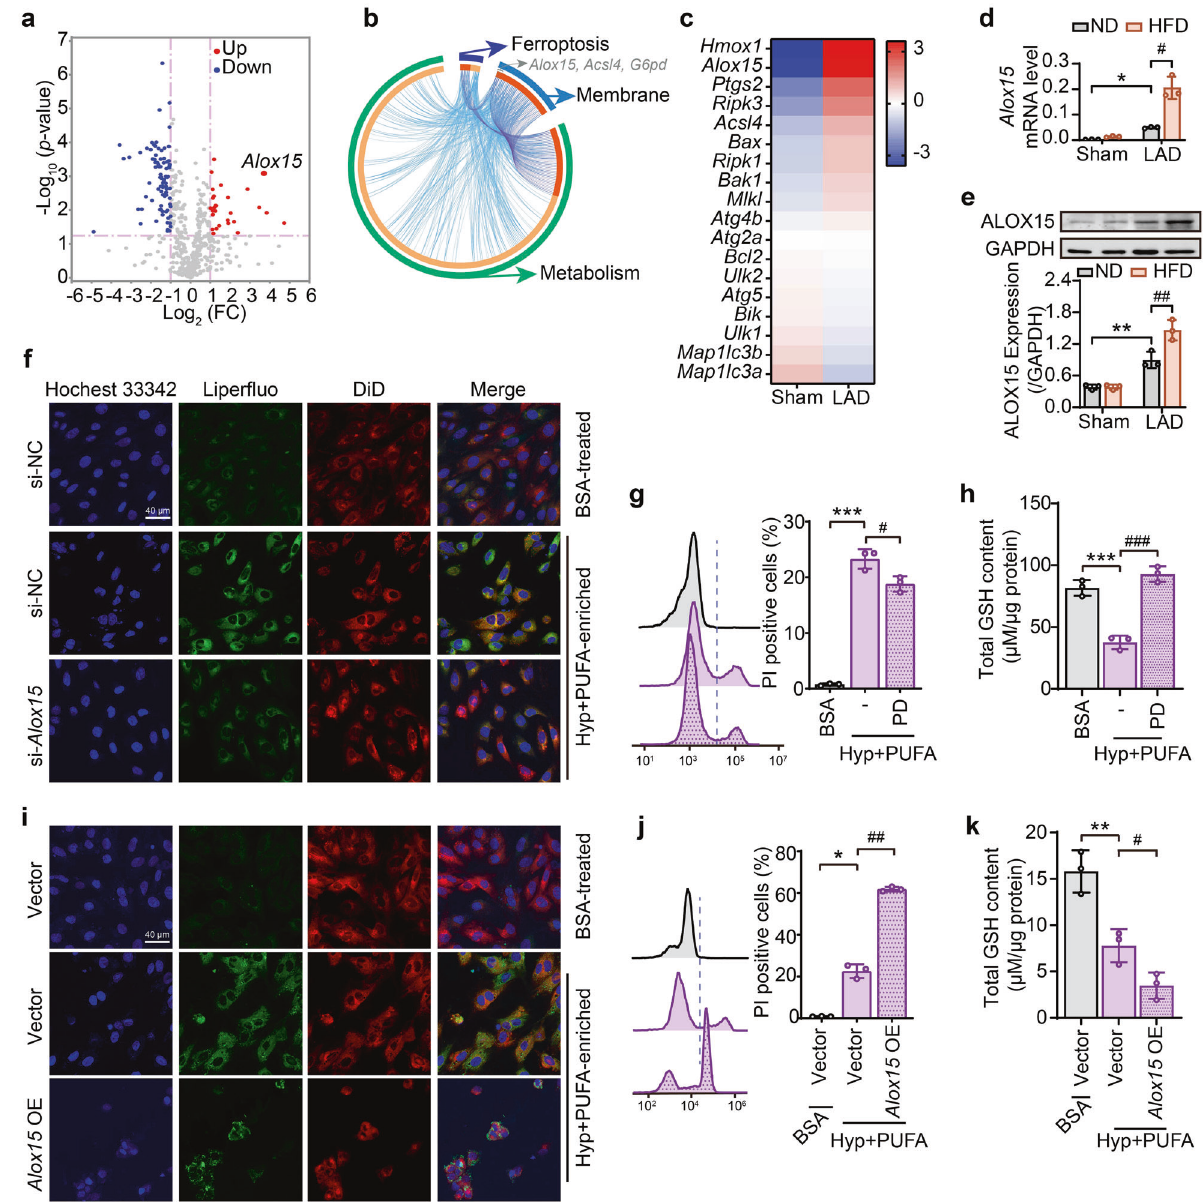
Fig. 3 ALOX15 expression is highly correlated with ischemia/hypoxia-induced cardiomyocyte damage. a – c The differential genes analysis in the heart tissues of sham and ischemia hearts. a The volcano plots express the differentially expressed genes between the two groups in metabolic pathways by KEGG analysis. The genes upregulated (red point) or downregulated (blue point) at least the absolute value of log2 (fold change) >1 and P < 0.05 was set as the thresholds between any two treatments ( n = 4). b The Circos plot indicates overlapped differential genes across ferroptosis, membrane and metabolic pathways. Outside of the Circos, each arc represents an identity pathway gene list, and inside, a spot on the arc represents a gene. The greater the number of purple links and the longer the dark orange arcs imply a more signi fi cant overlap among the input gene lists. Alox15 , Acls4 and G6pd were identi fi ed as the overlapping genes of three pathways. c Heat map of differential expressions of classical genes related to ferroptosis ( Hmox-1 , Alox15 , Ptgs2 , Acsl4 ), apoptosis ( Bax, Bcl 2 , Bik , Bak1 ), necrosis ( Ripk3 , Mlkl , Ripk1 ), and autophagy ( Atg4b , Atg2a , Ulk2 , Atg5 , Ulk1 , Map1lc3b , Map1lc3a ). Color scales show the differences in expression of each gene in the indicated sample relative to its expression in log 2 (fold change). The mRNA ( d ) and protein ( e ) levels of ALOX15 in heart tissues of ND-or HFD-fed rats after 24-h LAD ligation and the semi-quanti fi cation is shown in the lower panel. f After si- Alox15 , lipid peroxidation was detected by confocal microscopy after Liper fl uo staining in PUFA-enriched H9C2 cells under hypoxia. Effect of ALOX15 inhibitor PD 146176 (PD, 10 μ M) on cell death ( g ) and GSH content ( h ) was assessed by PI staining in PUFA-enriched H9C2 cells under hypoxia. After Alox15 overexpression ( Alox15 OE) in PUFA-enriched H9C2 cells under hypoxia, lipid peroxidation ( i ), cell death ( j ) and GSH content ( k ) were, respectively, determined by confocal microscopy, fl ow cytometry and HPLC-MS. All the quantitative data are presented as mean ± SD and statistical signi fi cance was assessed by one-way ANOVA followed by Tukey post-hoc test. For the in vitro experiments, * p < 0.05, ** p < 0.01, *** p < 0.001 vs control (Cont) group; # p < 0.05, ## p < 0.01, ### p < 0.001 vs hypoxia (Hyp) group. For the in vivo experiments, * p < 0.05, ** p < 0.01 vs “ ND + sham ” group, # p < 0.05, ## p < 0.01 vs “ ND + LAD ” group